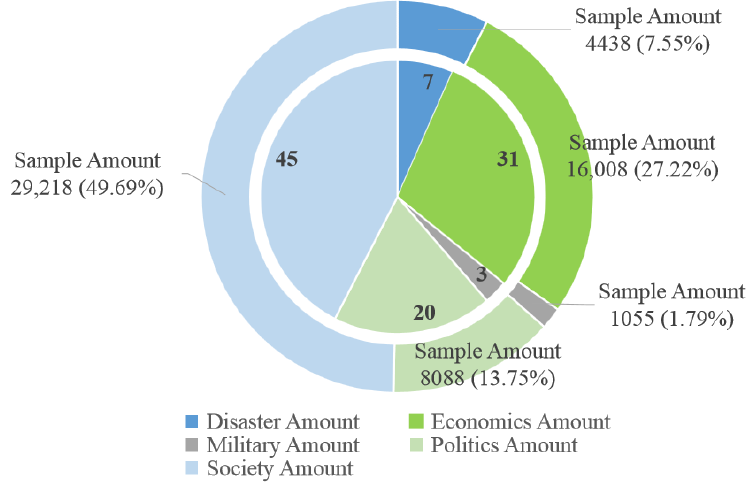
Figure 2. Microblog and sample quantities.